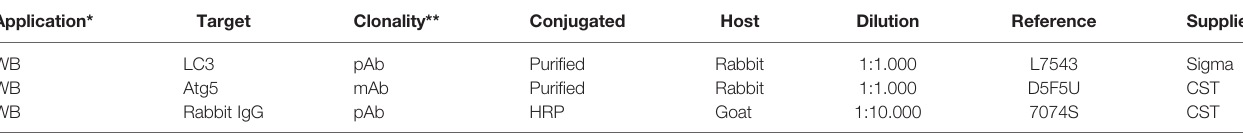
TABLE 1 | Antibodies list for Western blot